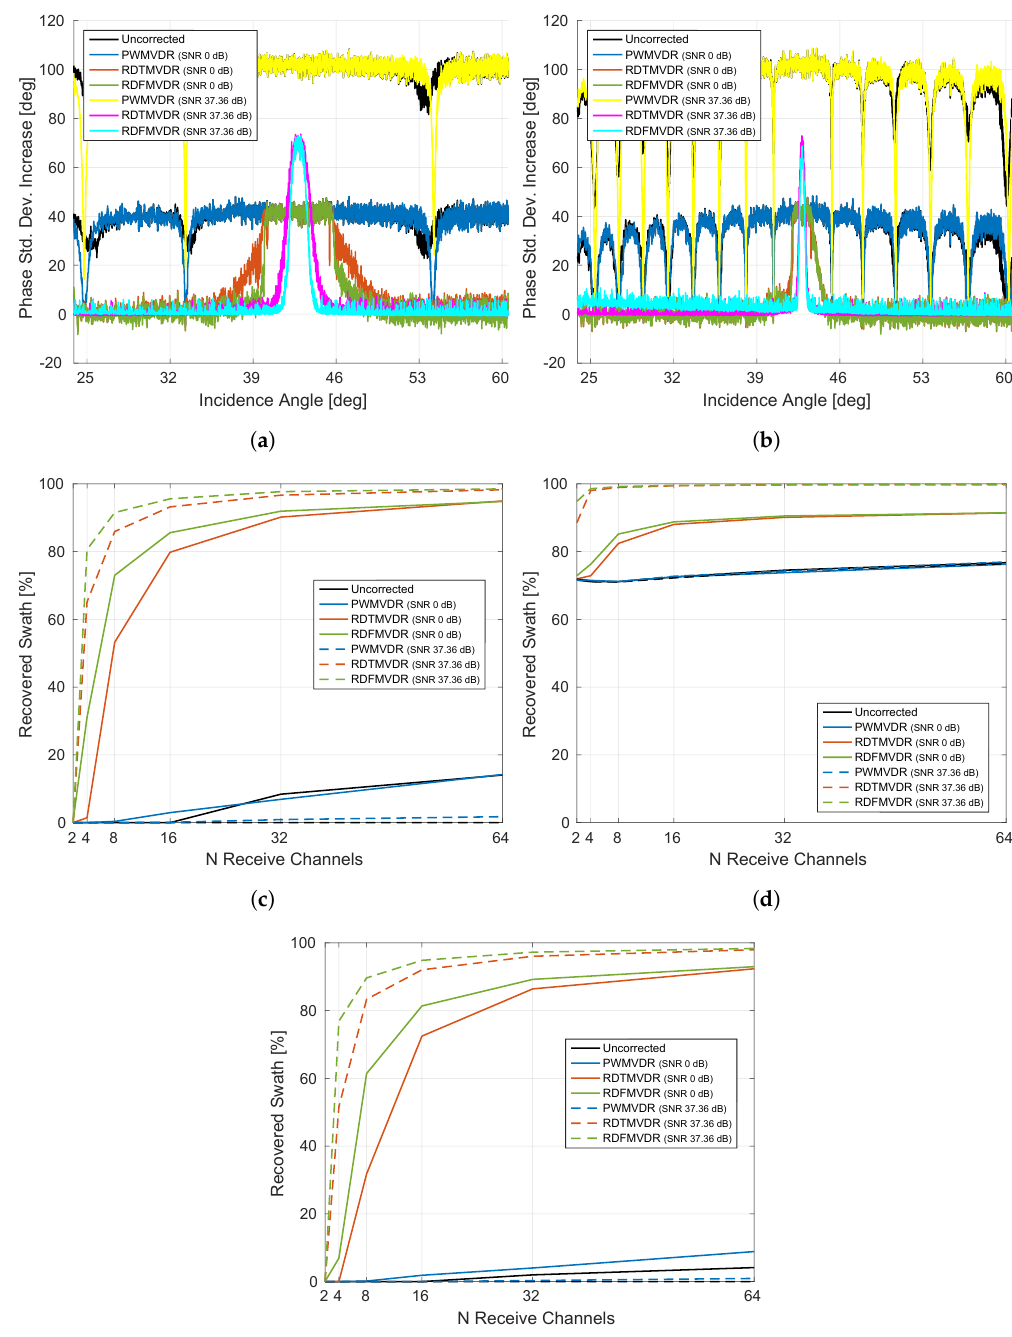
Figure 27. The phase standard deviation increase of the residual error image for scenario B at a RFI-Noise-Ratio of 40 dB. ( a ) Error plotted versus incidence angle for N = 16 and for SNR = 0 dB (pale lines) and SNR = 37.36 dB (saturated lines), ( b ) Error plotted versus incidence angle for N = 64 and for SNR = 0 dB (pale lines) and SNR = 37.36 dB (saturated lines), ( c ) The percentage of the recovered SAR swath that is within the phase std. dev. limits of 20°, ( d ) The percentage of the recovered SAR swath that is within the phase offset limits of 5°, ( e ) The percentage of the recovered SAR swath that is within the absolute gain limits of 0.5